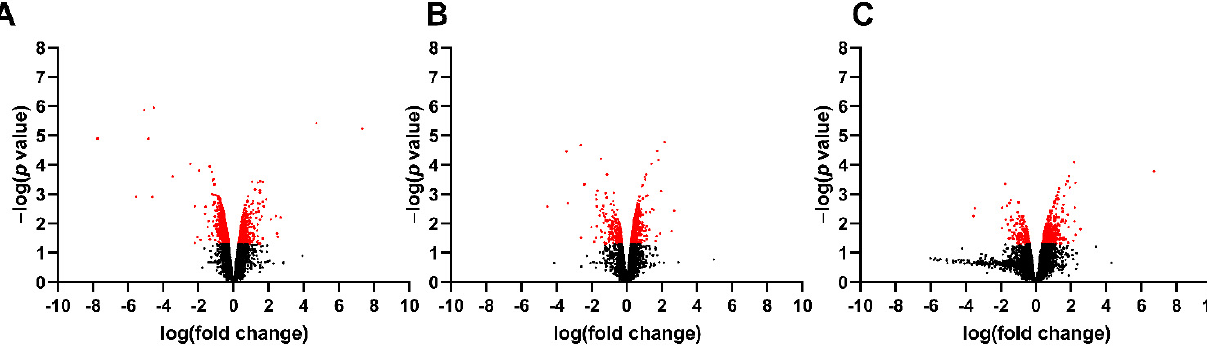
Figure 4. Volcano plot illustrating RNA-seq data of fetal spinal cords isolated from control and vehicle at ( A ) E15, ( B ) E17, and ( C ) E20. Red identifies genes that were greater than 1.5-fold change and p < 0.05.